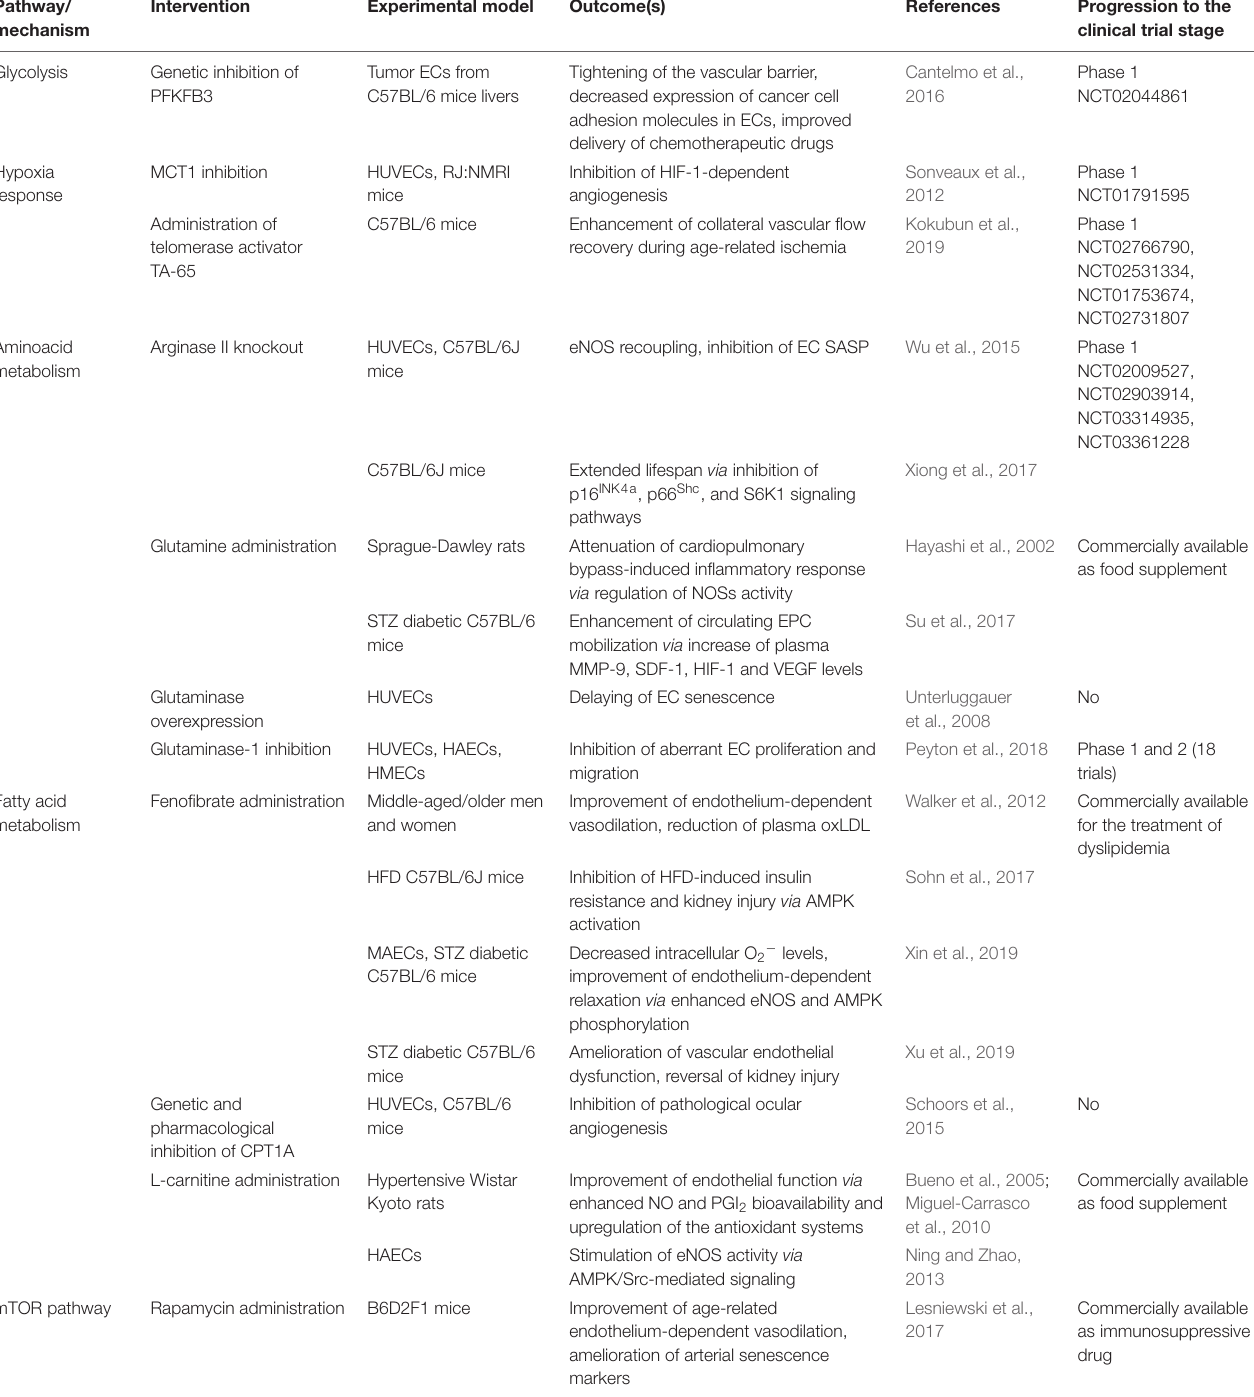
TABLE 1 | Summary of the interventions targeting endothelial cell metabolism with a potential role in the treatment of age-related diseases. Pathway/